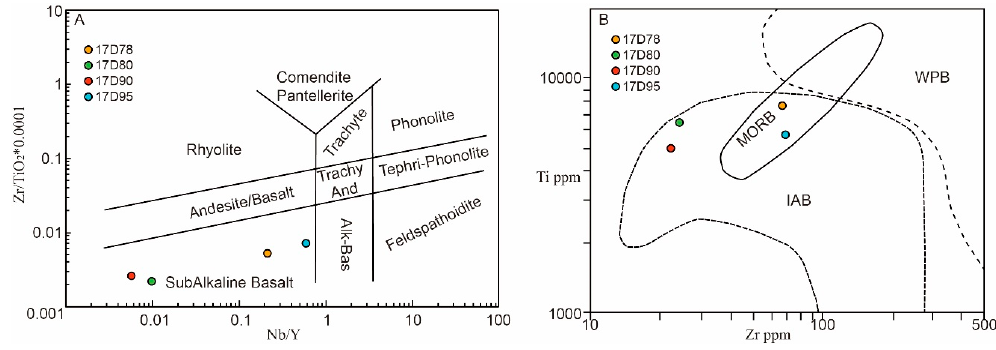
Figure 8. Classification of protoliths of garnet clinopyroxenite. ( A ) Nb/Y vs. Zr/TiO 2 plot (after Pearce [62]); and ( B ) Zr vs. Ti discrimination diagram (after Pearce [63]).